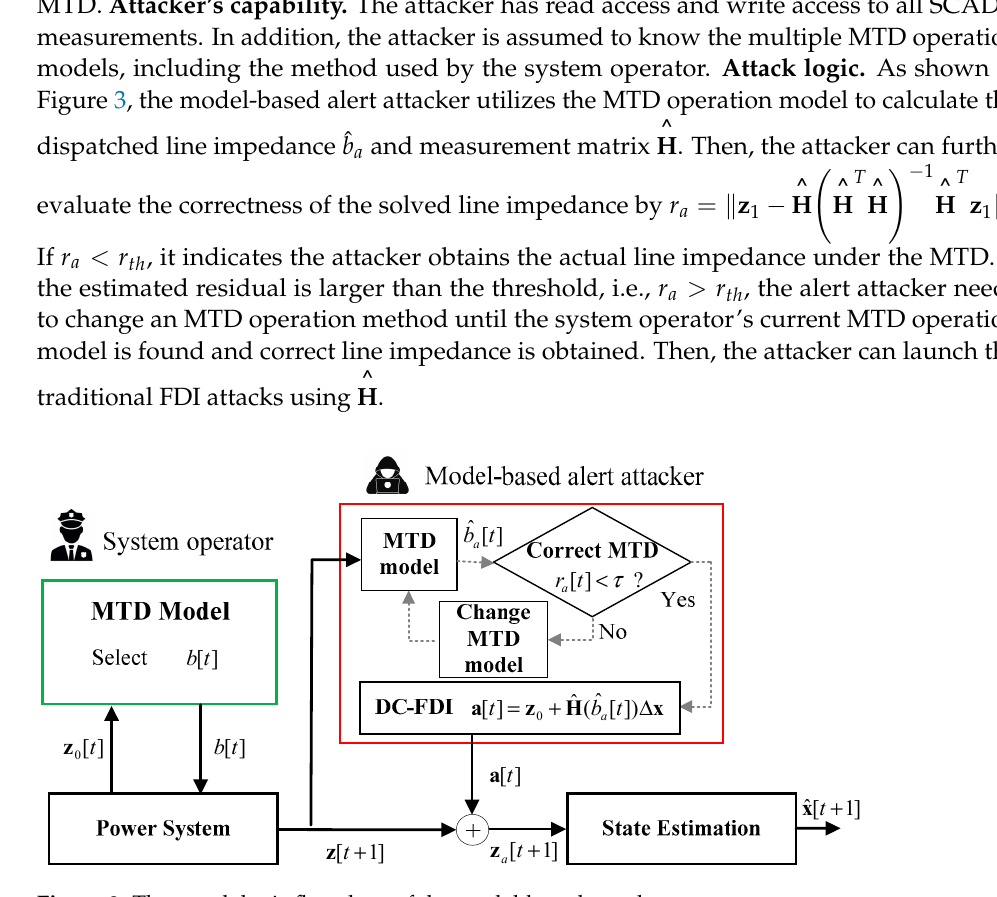
Figure 3. The attack logic flowchart of the model-based attacker.